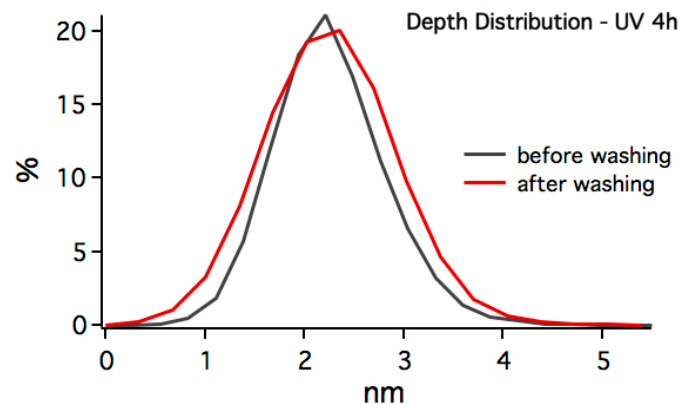
Figure 7. Depth distribution evaluated from the SFM images (Figure 6) before (black curve) and after (red curve) washing the ultra-thin film in ultra-pure water upon UV cleavage for 4 h.